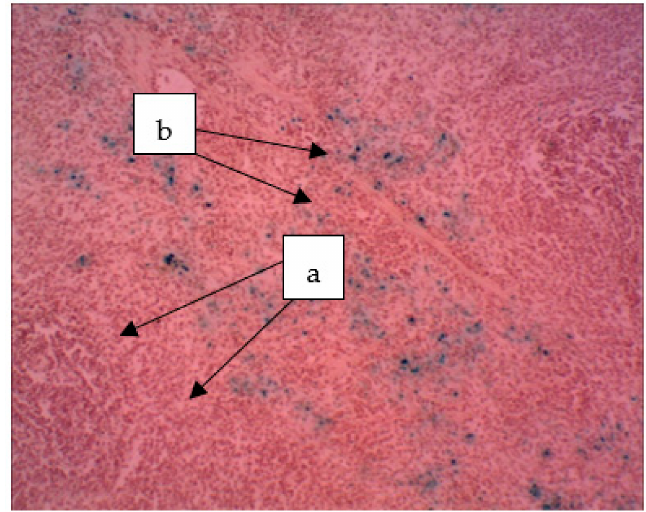
Figure 10. The spleen of a rat. The deposition of hemosiderin grains in the red pulp (a) and hemosiderin in the white pulp (b). The particles stained blue can be seen (a). × 400.